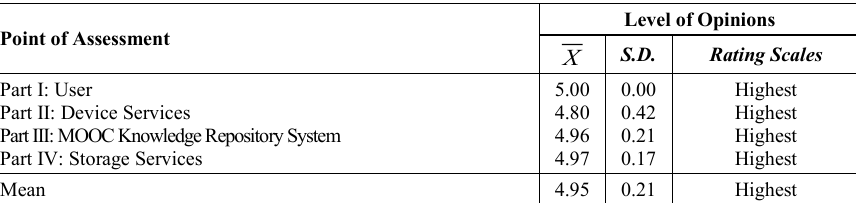
Table 3. The findings from architecture design of the MOOCs knowledge repository system using a digital knowledge engineering process suitability